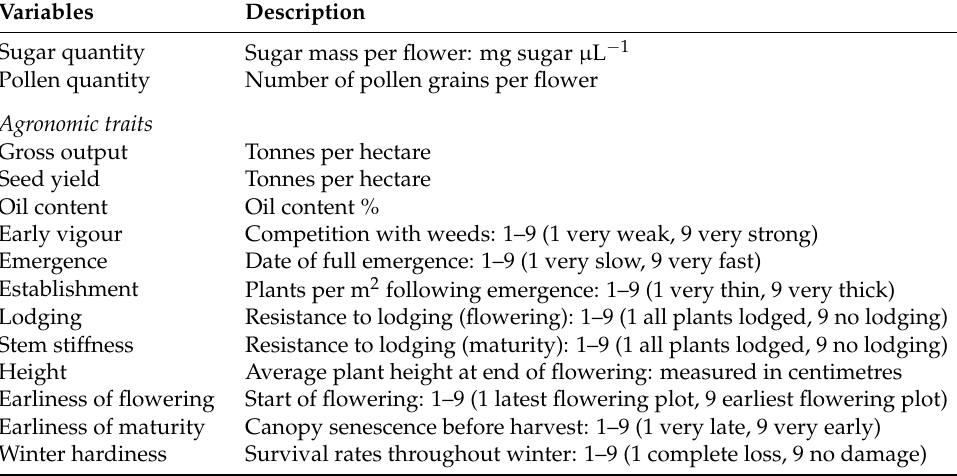
Table 1. Summary and description of response and dependent variables used in regression analyses. Agronomic traits were measured during varietal infield testing by the Agricultural and Horticultural Development